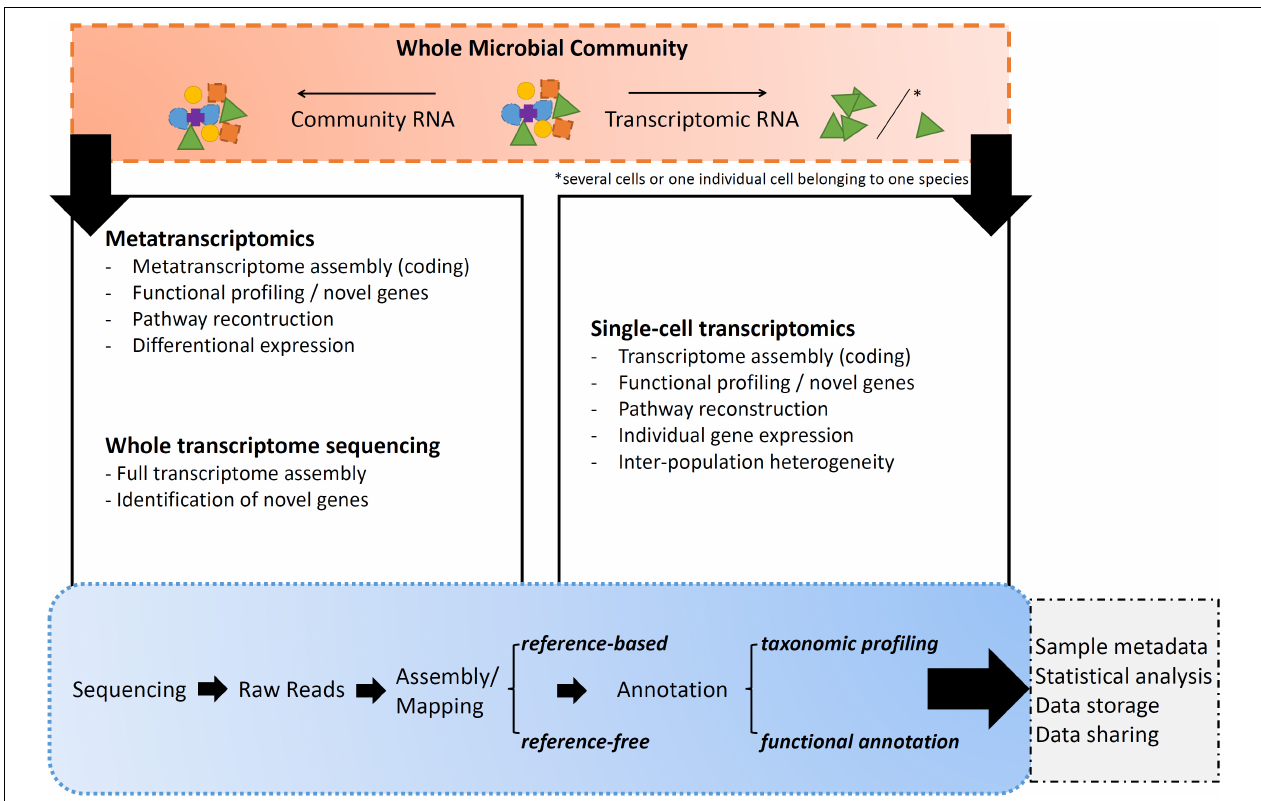
FIGURE 3 | Overall summary of the listed transcript*omics applications and their major